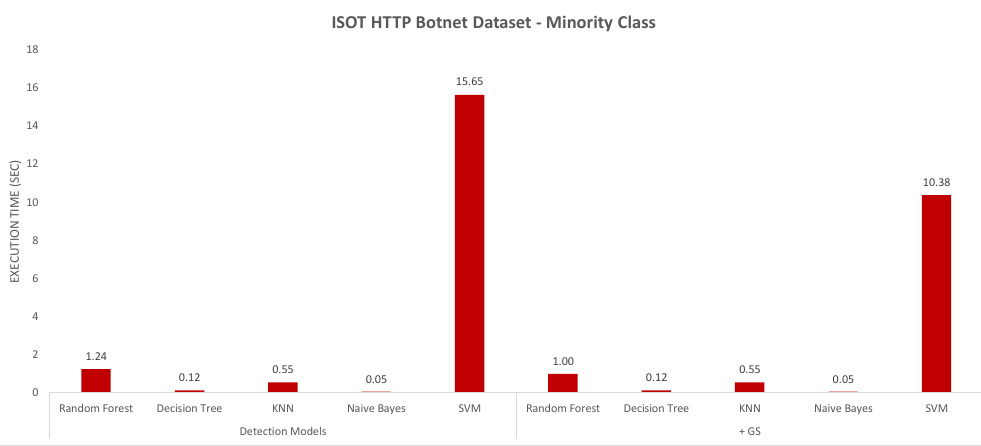
Figure 6. Execution time in the different models with minority class on the ISOT HTTP Botnet